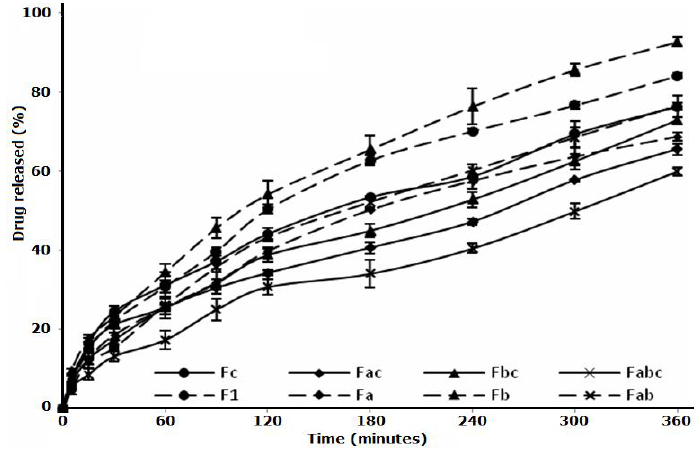
Figure 3. Drug release profiles of CAP gastro-floating